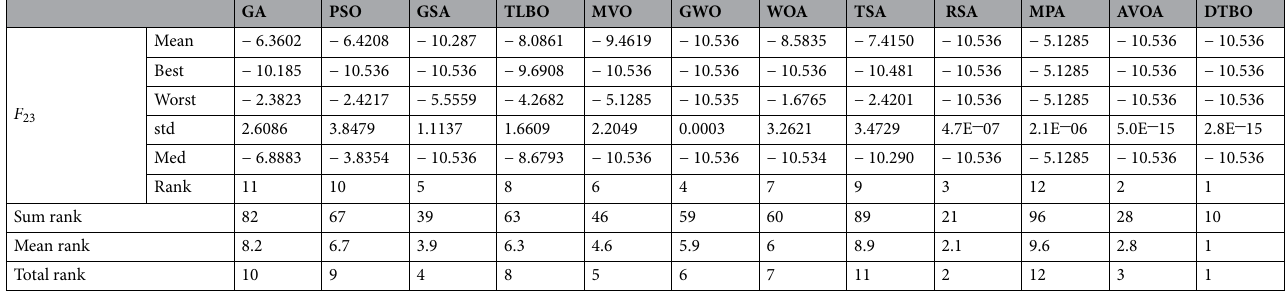
Table 4. Evaluation results of fixed-dimensional multimodal